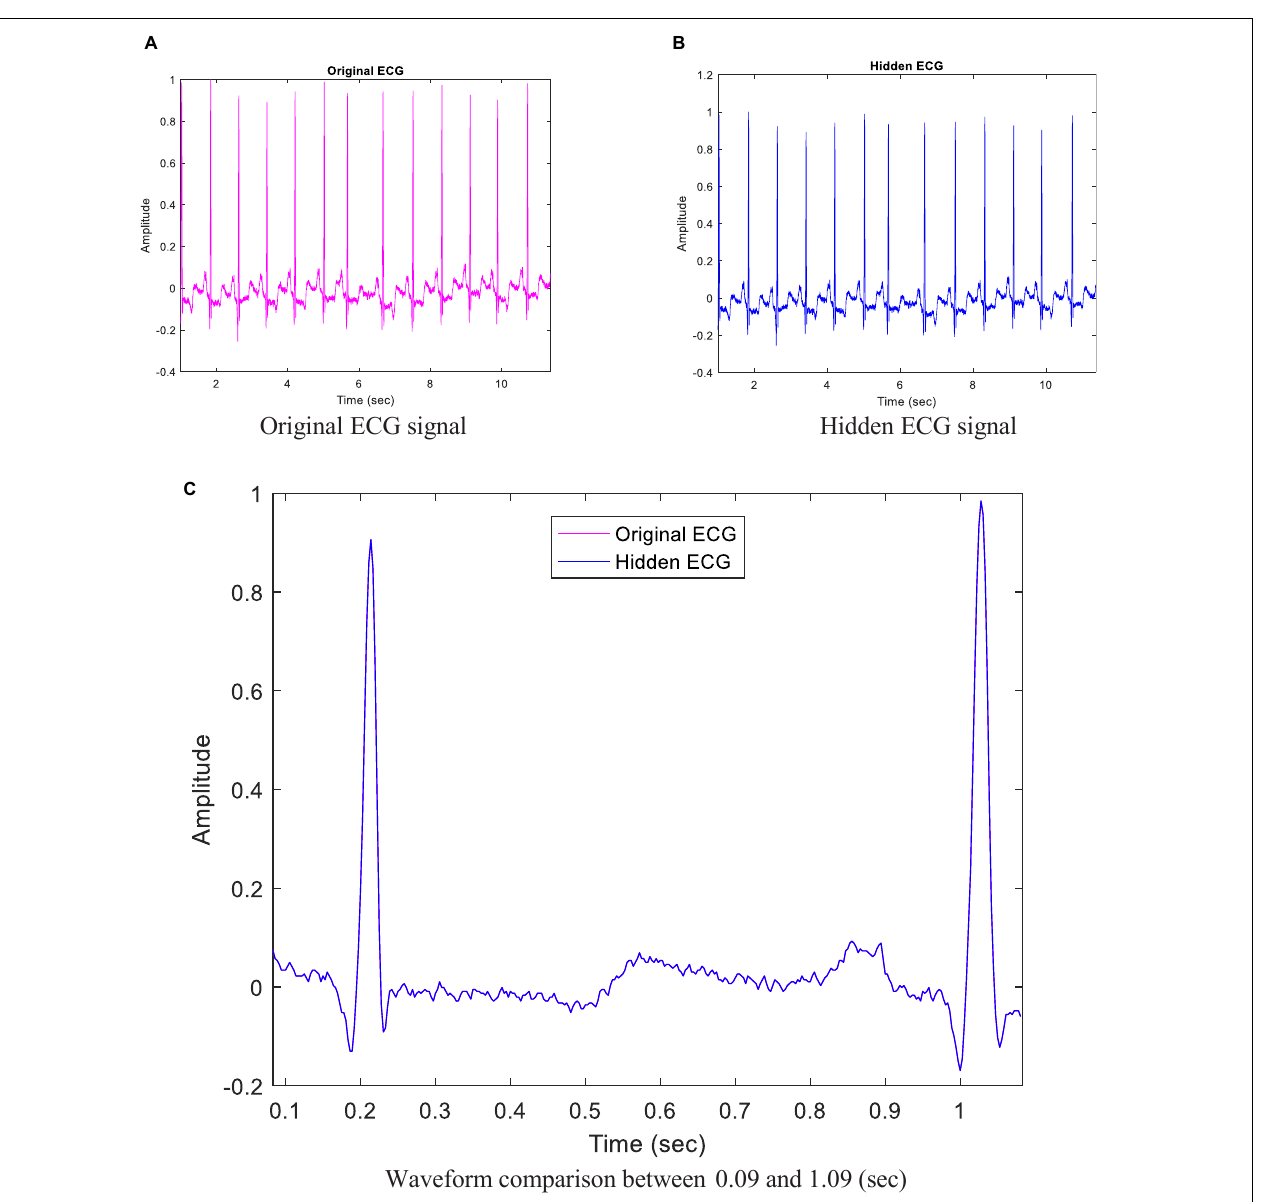
FIGURE 4 | Comparison between original electrocardiogram (ECG) signal and hidden ECG signal for dataset ID 1. (A) Original ECG signal. (B) Hidden ECG signal. (C) Waveform comparison between 0.09 and 1.09 s.